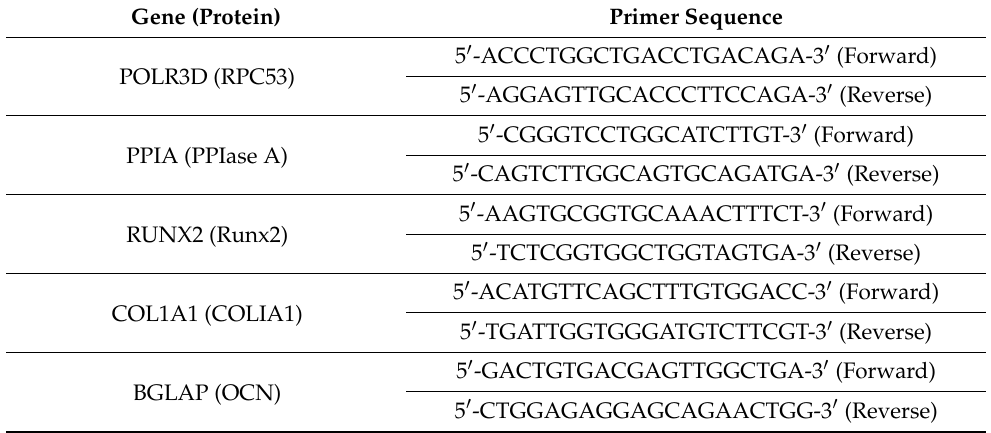
Table 1. Primers used for